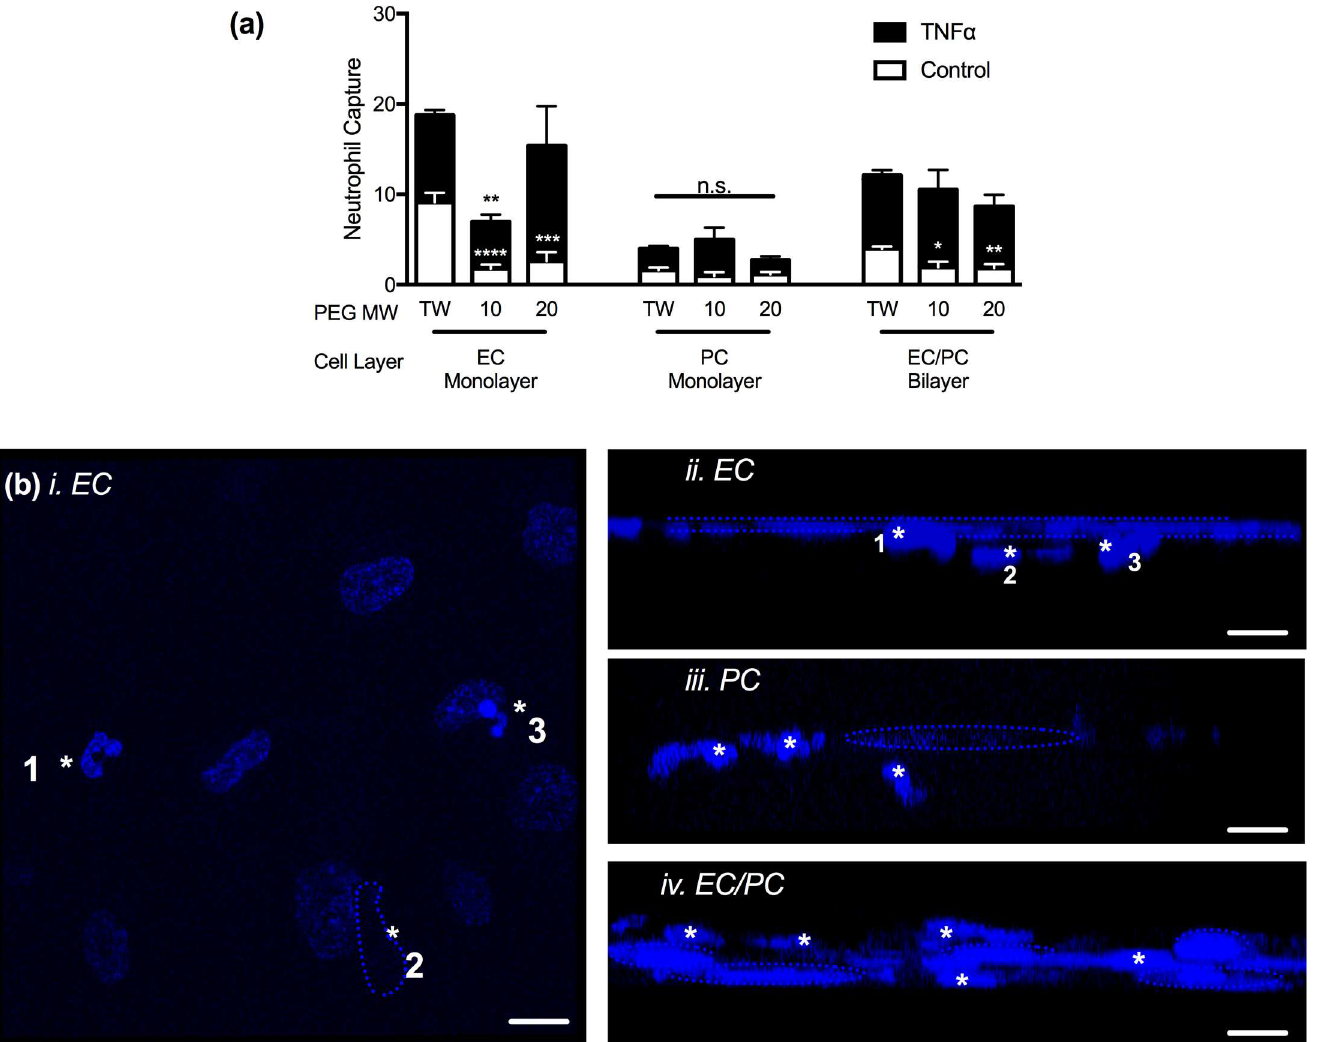
Fig 5. Neutrophil capture on with EC or PC monolayers or EC/PC bilayers. (a) Quantificationof neutrophilcapture within EC monolayers, PC monolayers, or EC/PC bilayerson transwells(TWs), 10kDa hydrogels, or 20kDa hydrogelsunder quiescentor TNF α -activated conditions. * p < 0.05, ** p < 0.01, *** p < 0.001, and **** p < 0.0001 when comparedto TWs under the same culture conditions. Unless noted, changesbetweenscaffolds are not significant.(b) Confocalmicroscopyresults of neutrophilsinteracting with cellularlayers on 20kDa hydrogelscaffolds. i and ii . Projection(i; * indicates three distinct neutrophils)and profile (ii; * neutrophils, dashed line outlinesEC nucleilayer) of an EC monolayerwith neutrophils. iii . Profile of PCs (dashed line outlines PC nucleus)and neutrophils( * denotesneutrophils). iv . EC/PC bilayer (apical layer: EC; basal layer: PC; dashedline outlines cell nuclei)and neutrophils( * denotes neutrophils). Scale bars are 10